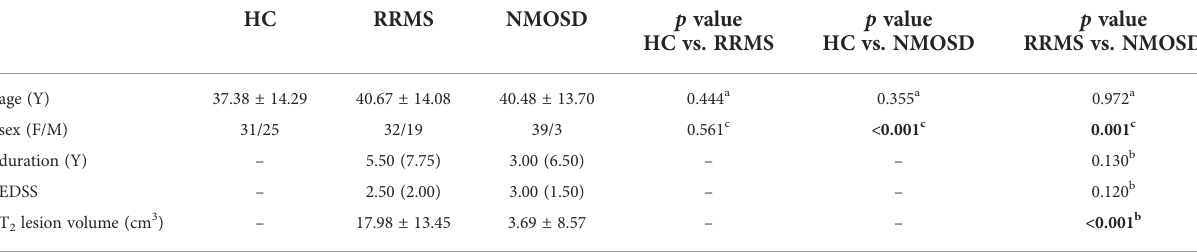
TABLE 1 Demographic, clinical and neuropsychological variables at cross-sectionally